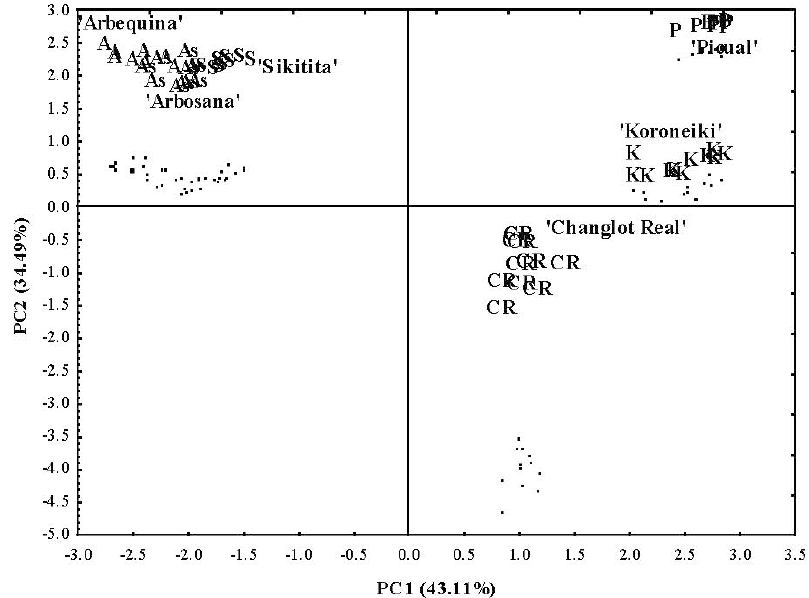
Figure 4. Scatter plots for the first and second principal components for the different cultivars. P (‘Picual’), K (‘Koroneiki’), CR (‘Changlot Real’), S (‘Sikitita’), As (‘Arbosana’) and A (‘Arbequina’).